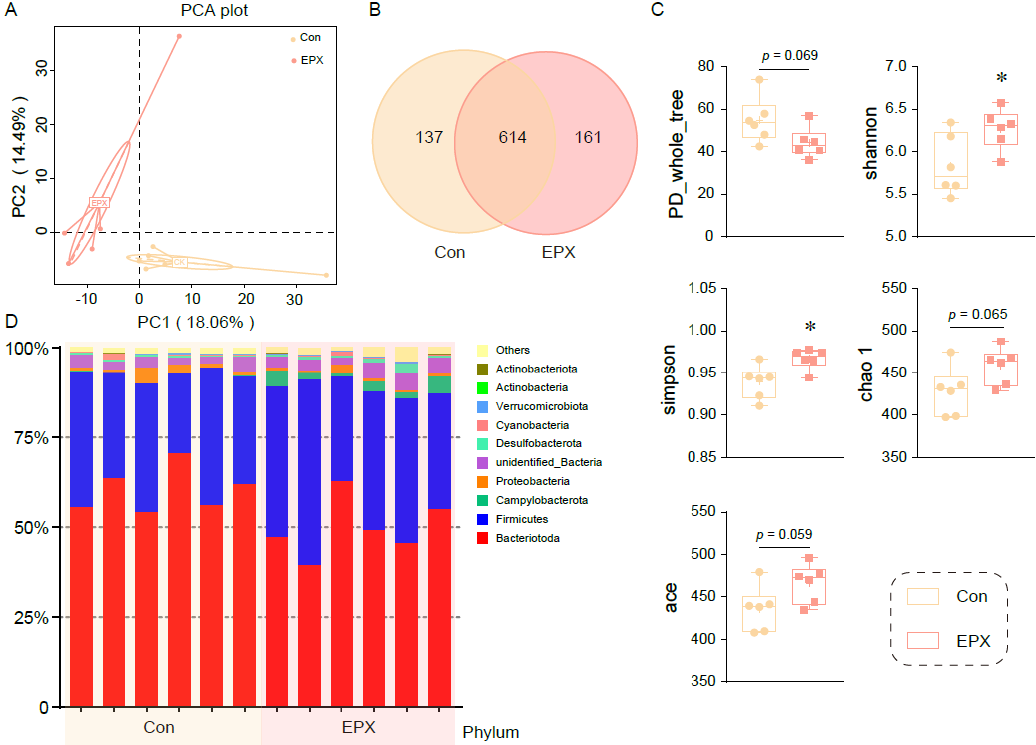
Figure 3. Effects of the oral exposure to EPX on the diversity of intestinal microbiota in the colon of mice ( n = 6). ( A ) Principal coordinate analysis (PCoA) of OTUs. ( B ) Venn diagram of the OTUs numbers. ( C ) The relative abundance of the top － 10 at the phylum level. ( D ) The indices of alpha diversity: PD_whole_tree, Shannon, Simpson, chao 1, ace. Values are shown as the means ± SEM ( n = 6), and statistical significance: p < 0.05 *.